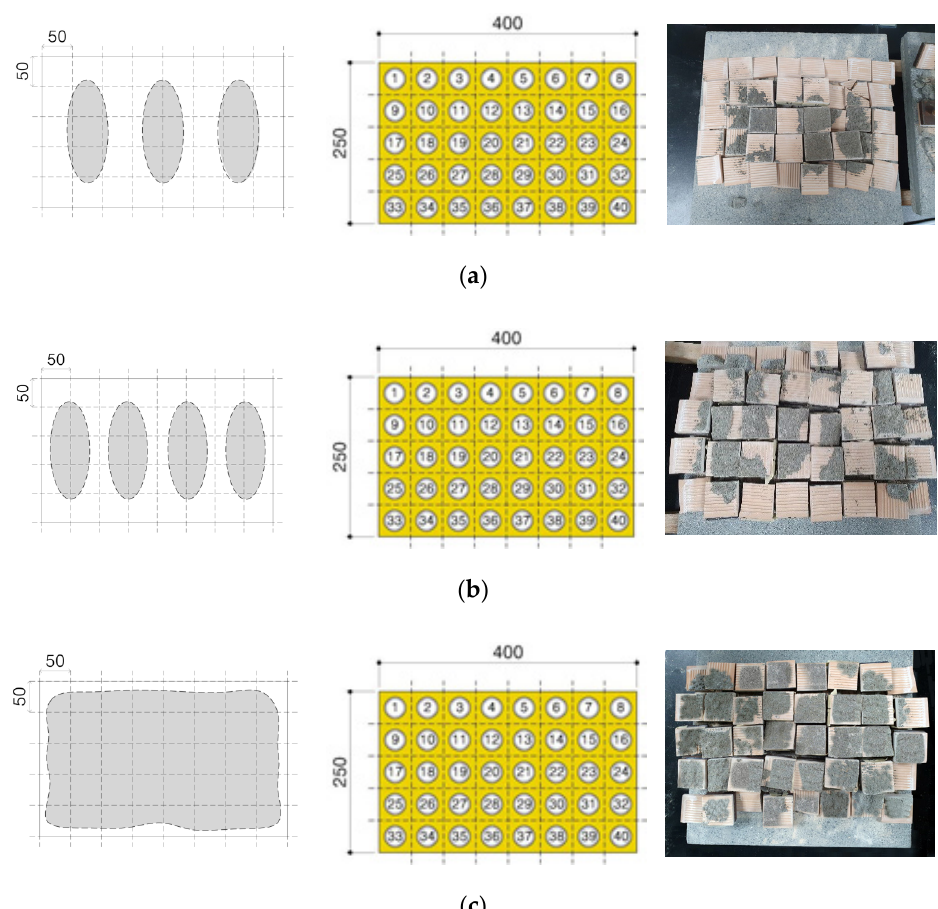
Figure 12. Sectioned pieces adhesion strength (pull-off) evaluation method: ( a ) 60 ± 2% specimen (units: mm); ( b ) 80 ± 2% specimen (units: mm); ( c ) 100% specimen (units: mm).